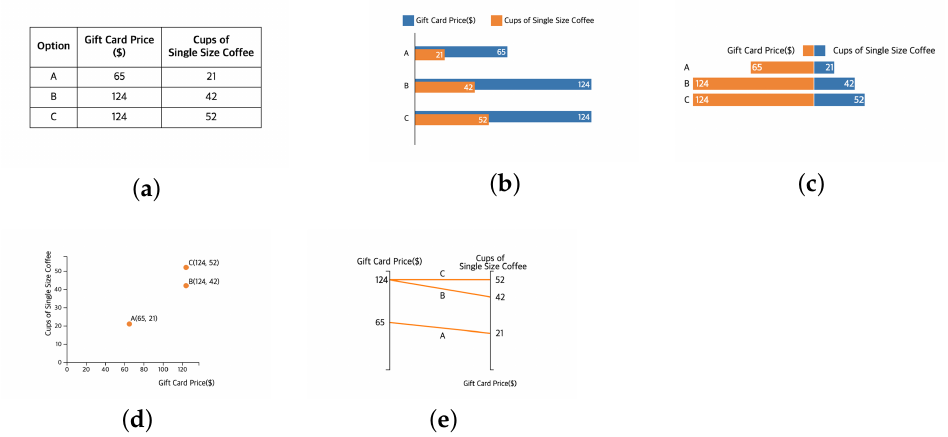
Figure 3. Examples of experimental stimuli. Four visualizations and a table for a baseline: ( a ) Table, ( b ) One-Sided Bar Chart, ( c ) Two-Sided Bar Chart, ( d ) Scatterplots, and ( e ) Parallel-Coordinate